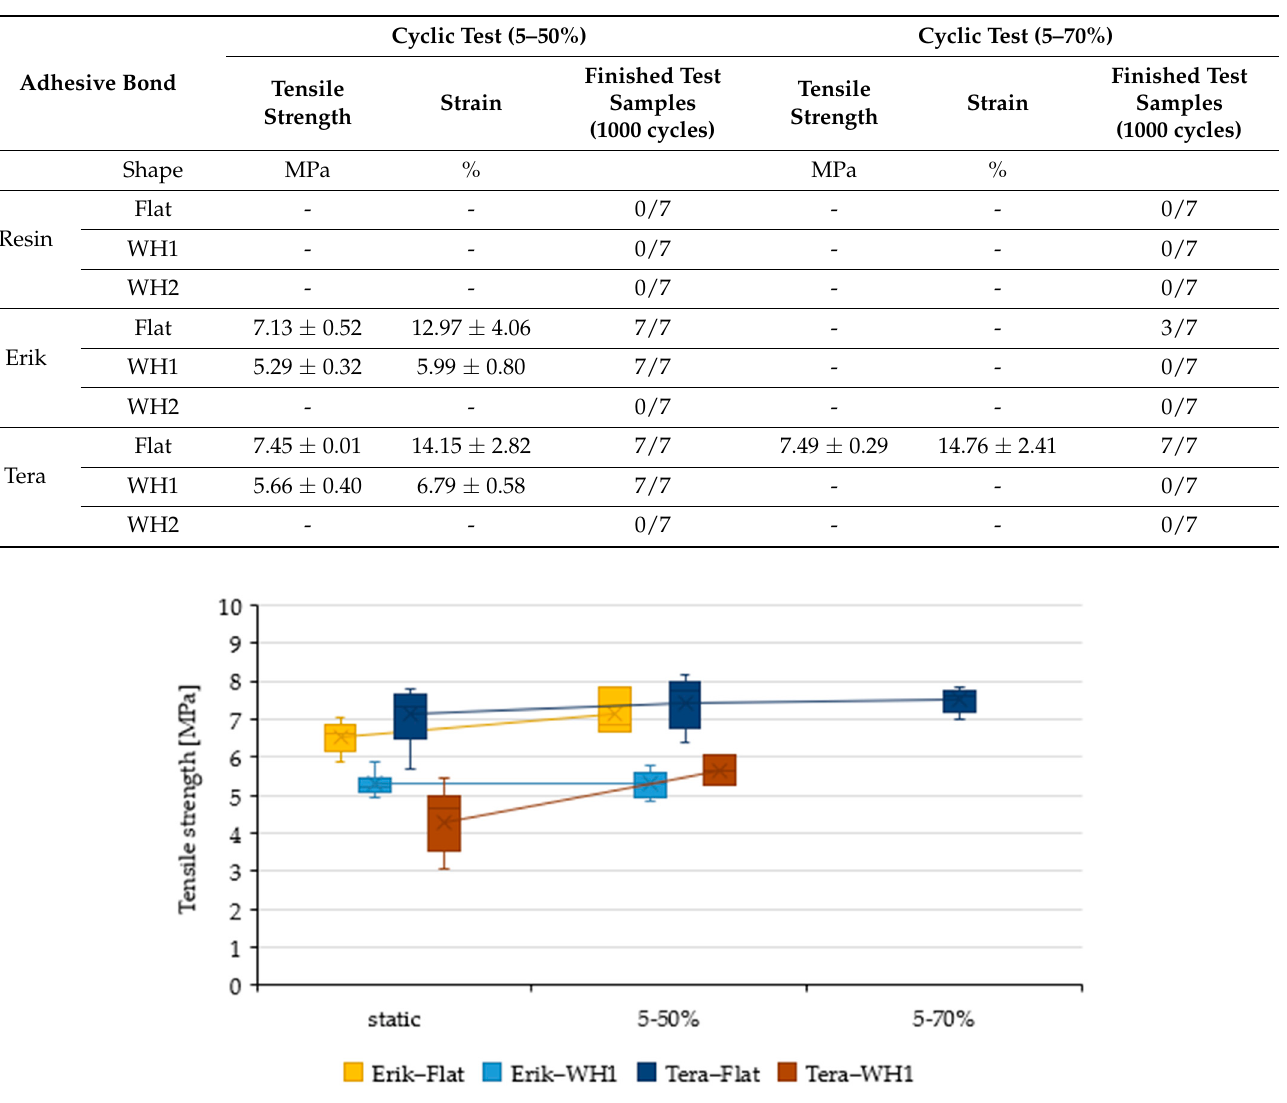
Table 6. Results of cyclic tensile tests of adhesive bonds in the load intervals 5–50% and 5–70%.